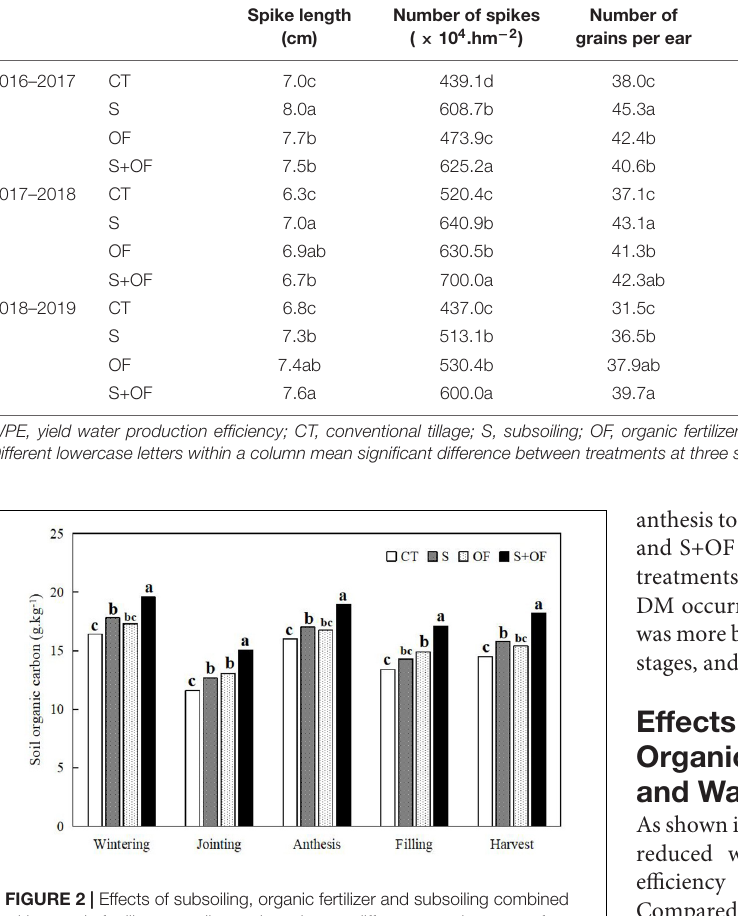
In addition, during the 3-year experiment, S+OF treatment led to the highest soil water